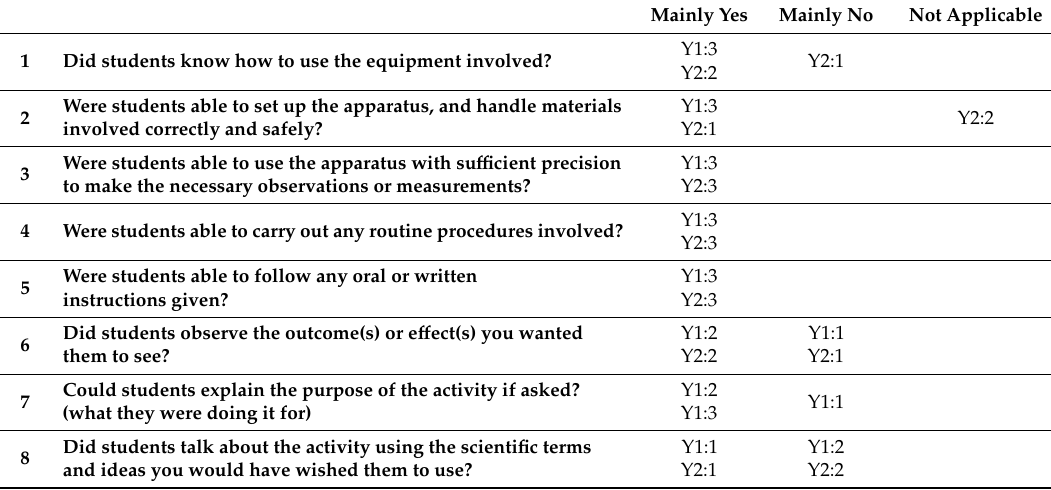
Table 3. E ff ectiveness of practical work at Level 1. Summary of practical work lessons (six in total) that meet each criterion. Modified table by Millar [18] (p. 24). Mainly Yes Mainly No Not